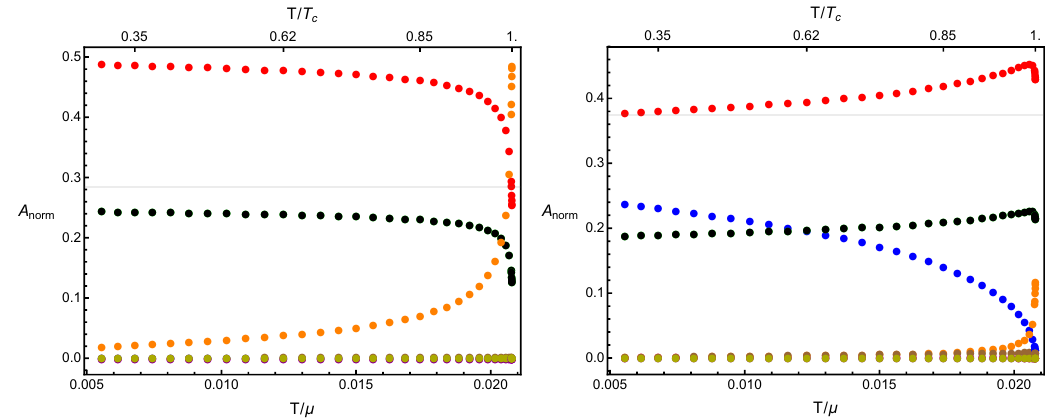
Figure 8 . The amplitudes of the various operators (4.7) for first (left panel) and second (right panel) sound normalized to T at fixed k/T = 0 . 01 . The inset is a non-logarithmic presentation of the same curves to show the ratio of approximately 0 . 5 between pressure and energy fluctuations. The color scheme is that illustrated in (4.7).